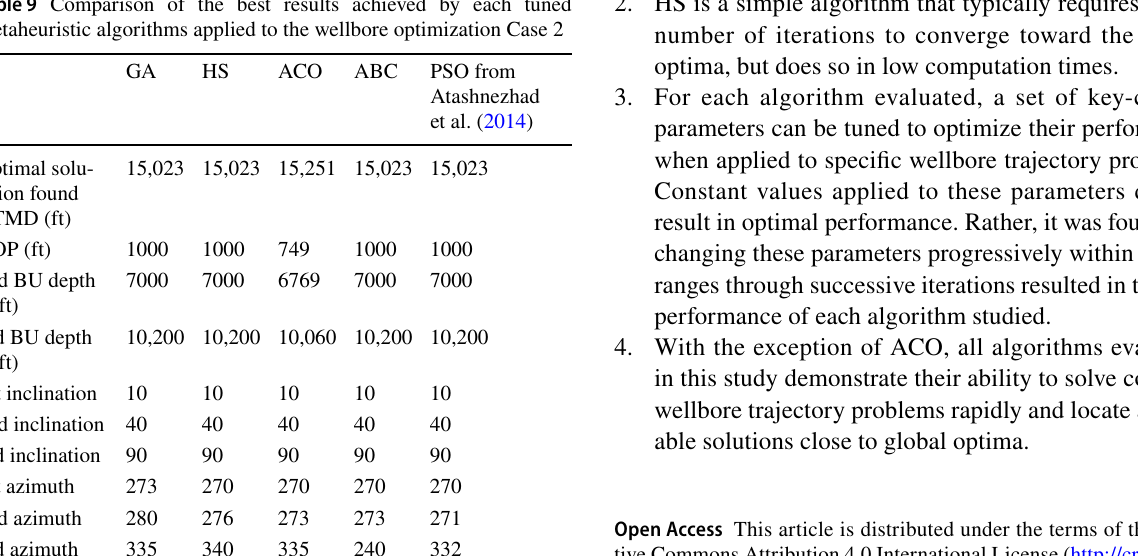
Table 9 Comparison of the best results achieved by each tuned metaheuristic algorithms applied to the wellbore optimization Case 2 GA HS ACO ABC PSO from Optimal solu- tion